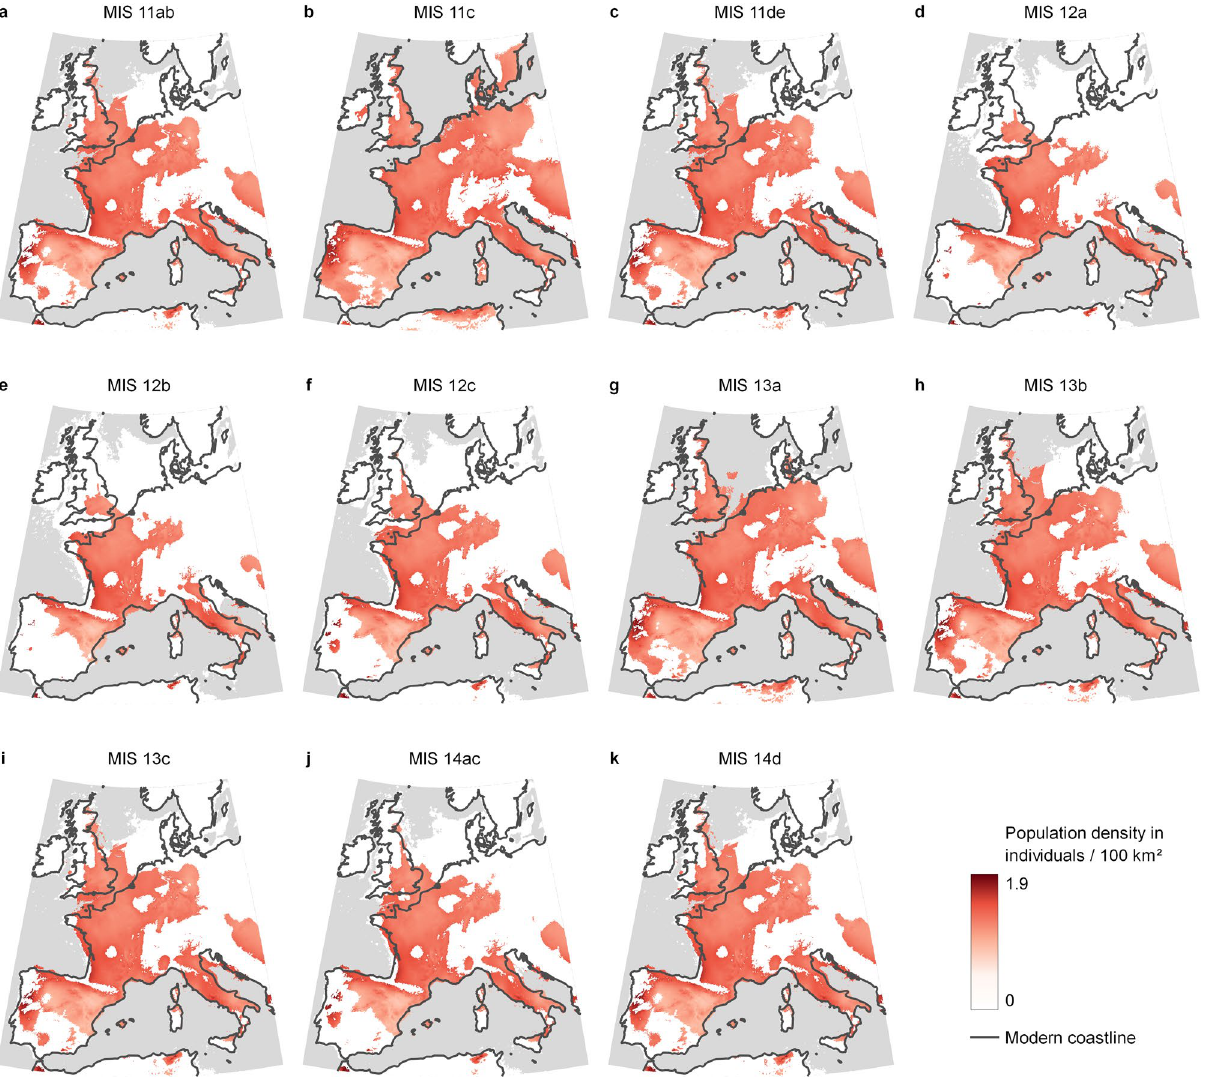
Figure 5. Population density in Western Europe from MIS14 to MIS11. The maps were created in QGIS 3.22 (https:// www. qgis. org). in the areas considered suitable for humans based on the SDM. The maps illustrate the lower limit of the estimated interval for population